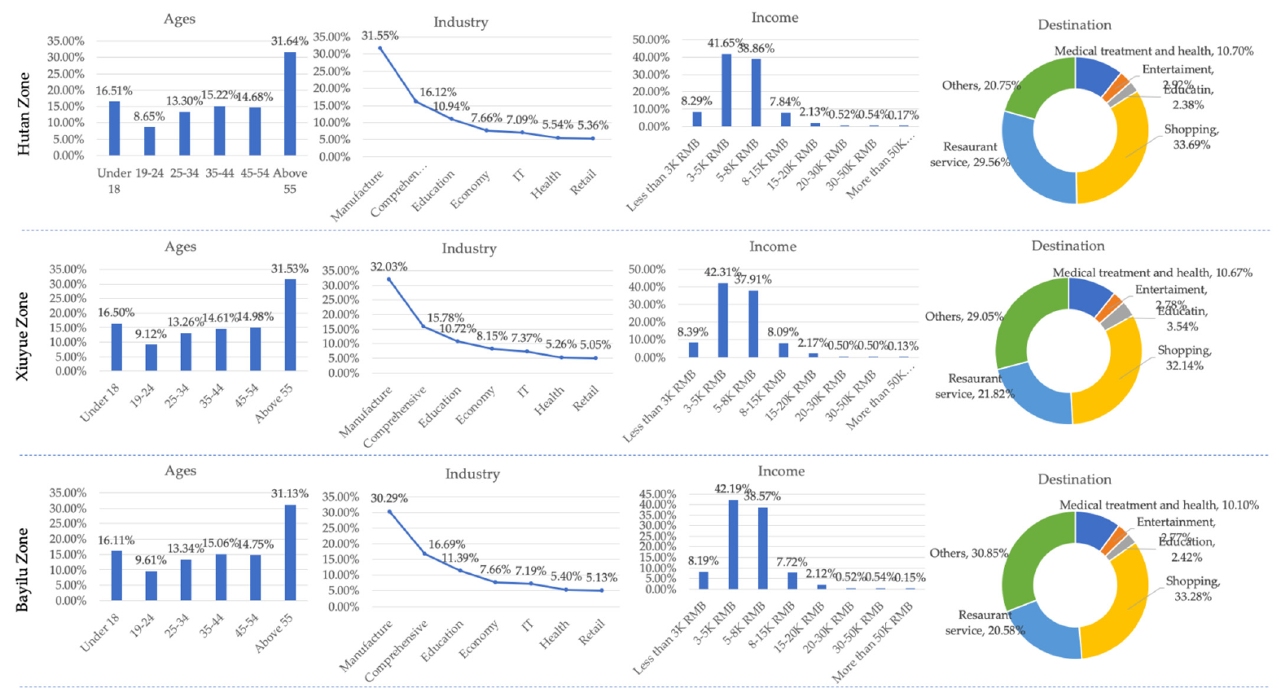
Figure 3. Data analysis of the selected zones of Dalian. Source: Authors.